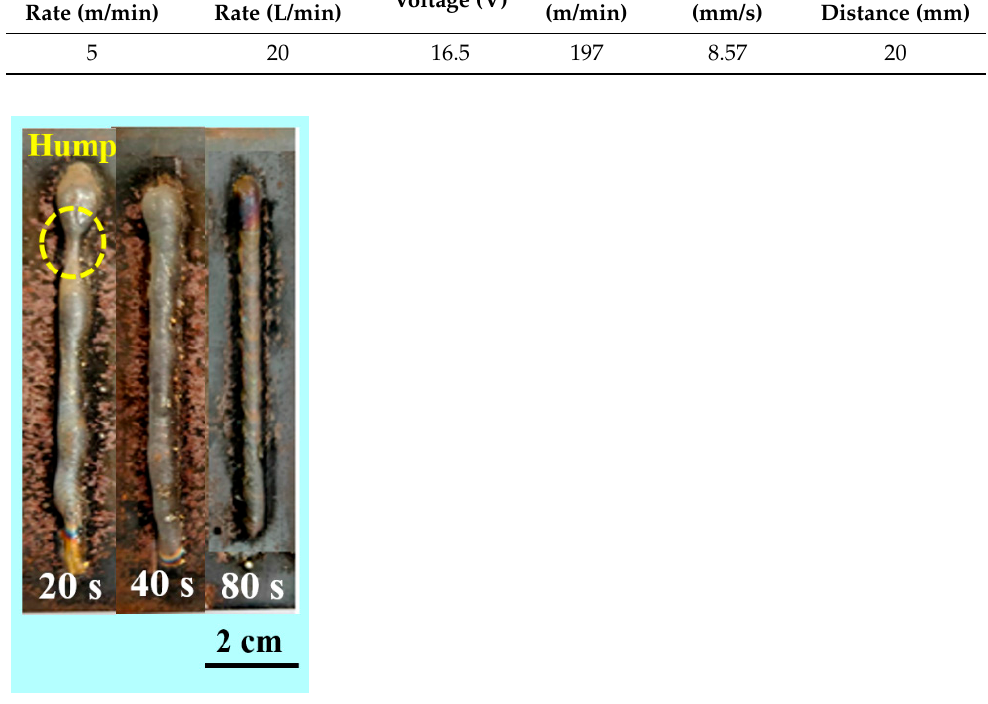
Figure 1. WAAM deposited walls with different thermal delay. Table 2. Optimized parameters for the Wire Arc Additive Manufacturing (WAAM) deposition.